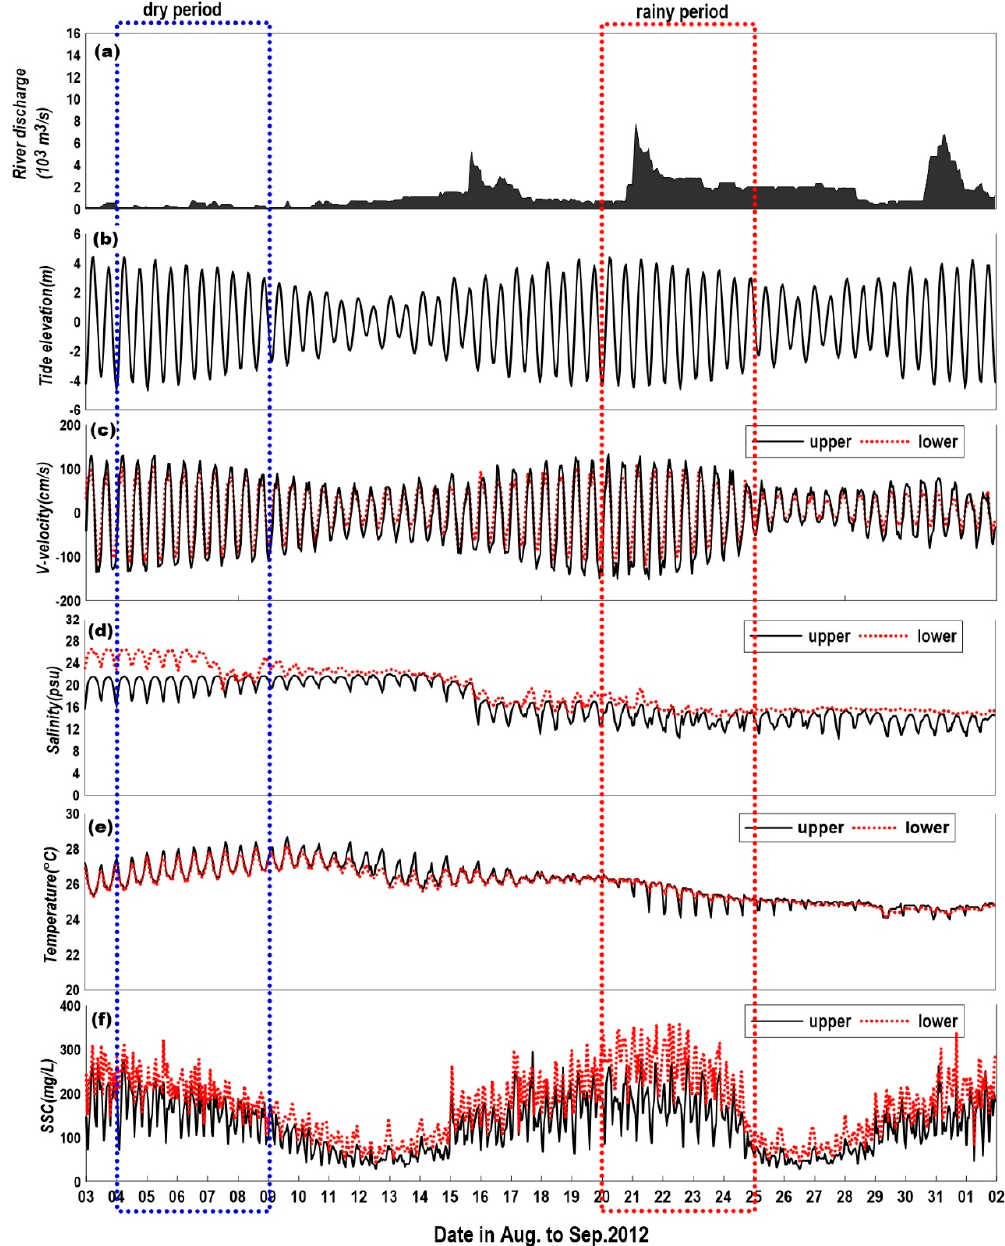
Figure 2. Classification of the dry and the rainy period during the summer in 2012: ( a ) freshwater discharge from Han River, ( b ) tide elevation of Incheon station, ( c ) horizontal flow velocity ( + : north, − : south), ( d ) salinity, ( e ) temperature, and ( f ) SSC.